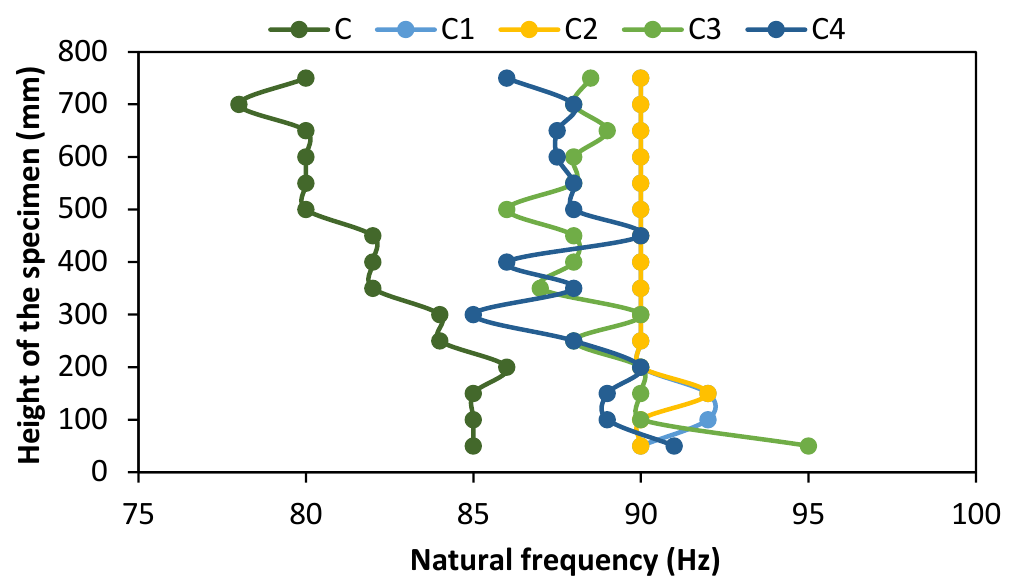
Figure 28. Observed natural frequency with respect to the height of the specimens. The calculated damping ratios for the specimens are given in Figure 29. The overall calculated damping ratio was found to be less than 1, which falls under the category of an underdamped system. The damping ratio for the nonheated specimen was 0.1336. Among the heated specimens, specimen C4 has the highest damping ratio, and specimen C1 has the lowest damping ratio. This proves that the loss of moisture content was minimal while heating the specimens to the C4 condition. The faster heat transfer helps specimen C4 maintain its moisture content to a considerable level. This could significantly improve the stability of the column under seismic conditions, as it has a higher damping ratio than the other heated specimens. Specimen C4 could work effectively under the simultaneous action of fire and lateral loads or seismic loads.